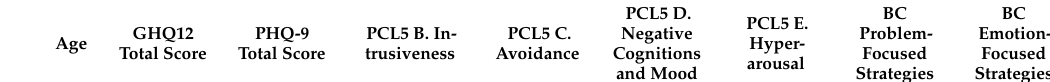
Table 8. Correlations among the age of volunteers, GHQ-12, PHQ-9 total scores, the 4 dimensions (B-E criteria of DSM-5) of the PCL5, and the 3 Brief-Cope coping styles identified by “Problem-focused strategies”, “Emotion-focused strategies” and “Dysfunctional coping strategies” ( n =